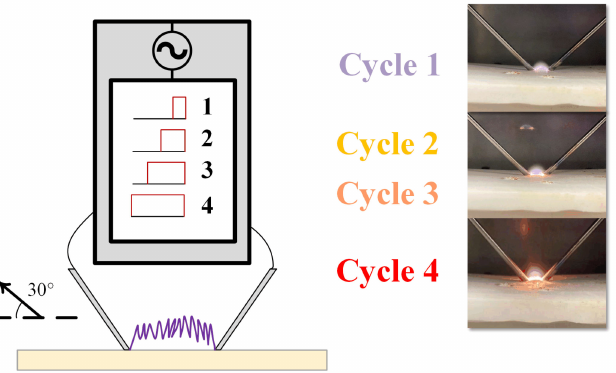
Figure 2. Dry-arc resistance test with images of the test during the 4 cycles of